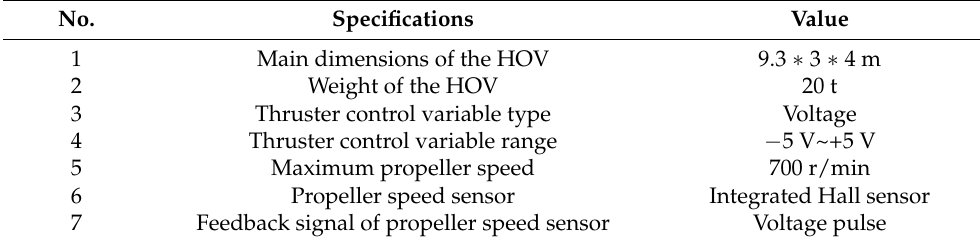
Table 1. Specifications of the HOV.